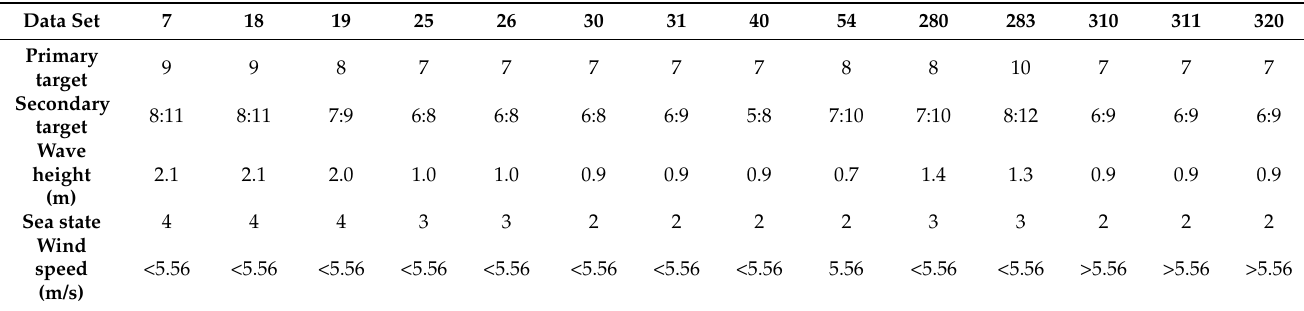
Table 1. Target information and sea conditions of the 14 data sets of the 1993 IPIX